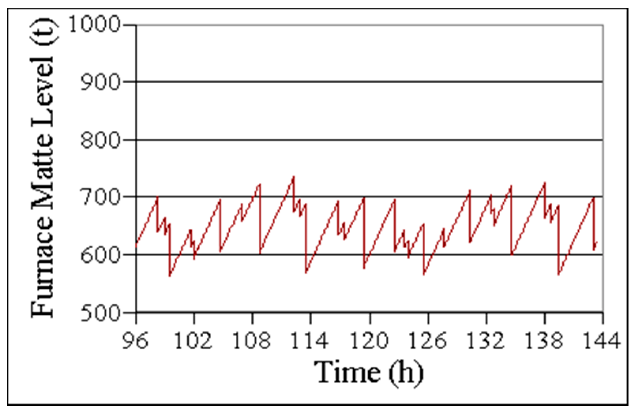
Figure 10. Matte level of smelting furnace with data from Table 1, Table 2, and Table 4, in which exceeding 700 triggers three long cycles, 30% of short cycles are extended, and 20% of long cycles are extended.